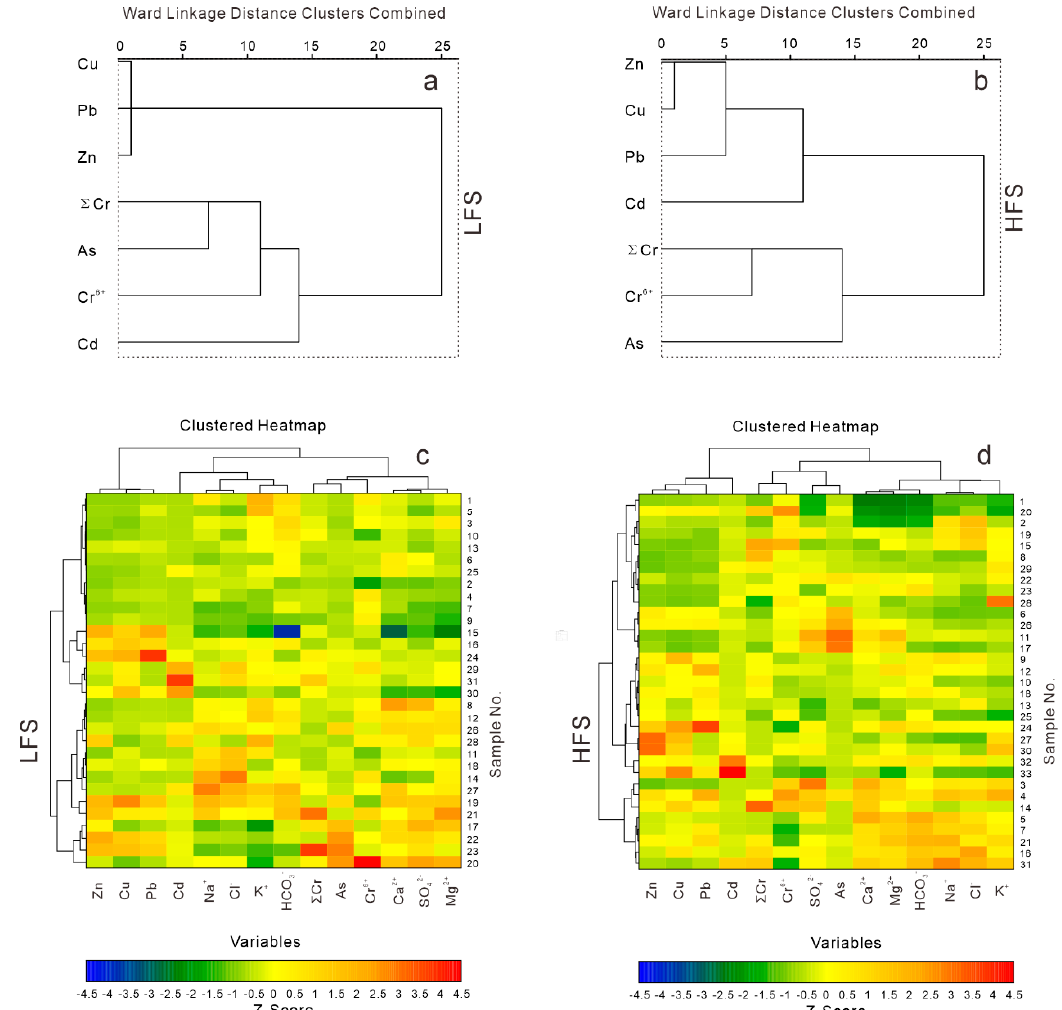
Figure 6. Dendrograms of the hierarchical clustering of the potentially toxic elements (( a ) for LFS period and ( b ) for HFS period) and two-way cluster analysis of the river water samples and chemical compositions (( c ) for LFS period and ( d ) for HFS period).